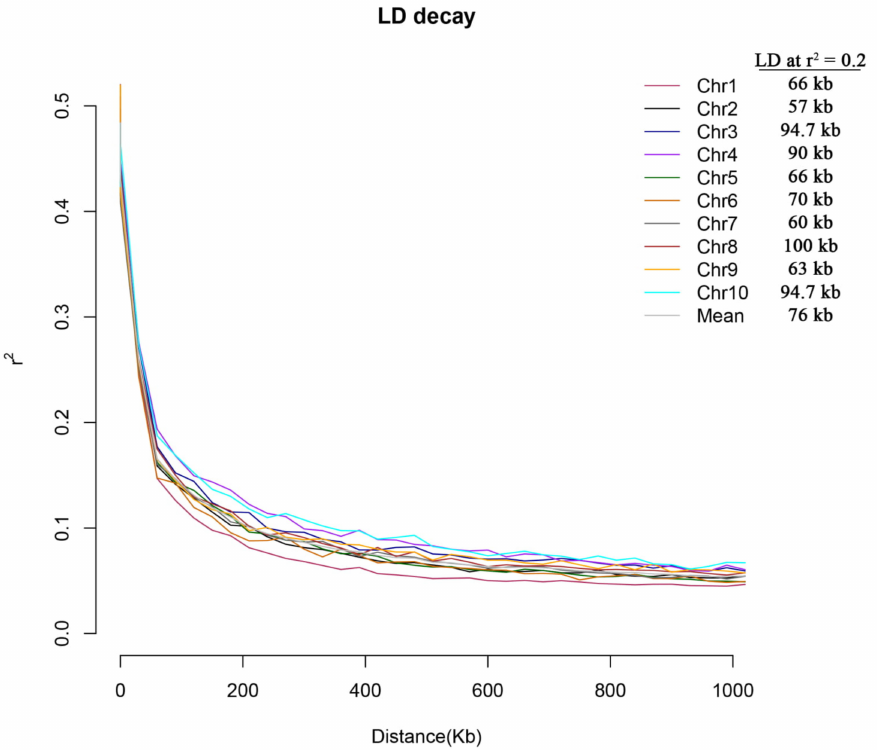
Figure 2. Overall chromosome-wide linkage-disequilibrium (LD) decay estimated from single- nucleotide polymorphism (SNP) genotypes of 250 maize lines. Each line plot represents a smoothed R 2 for all marker pairs on each chromosome depending on the distance between marker